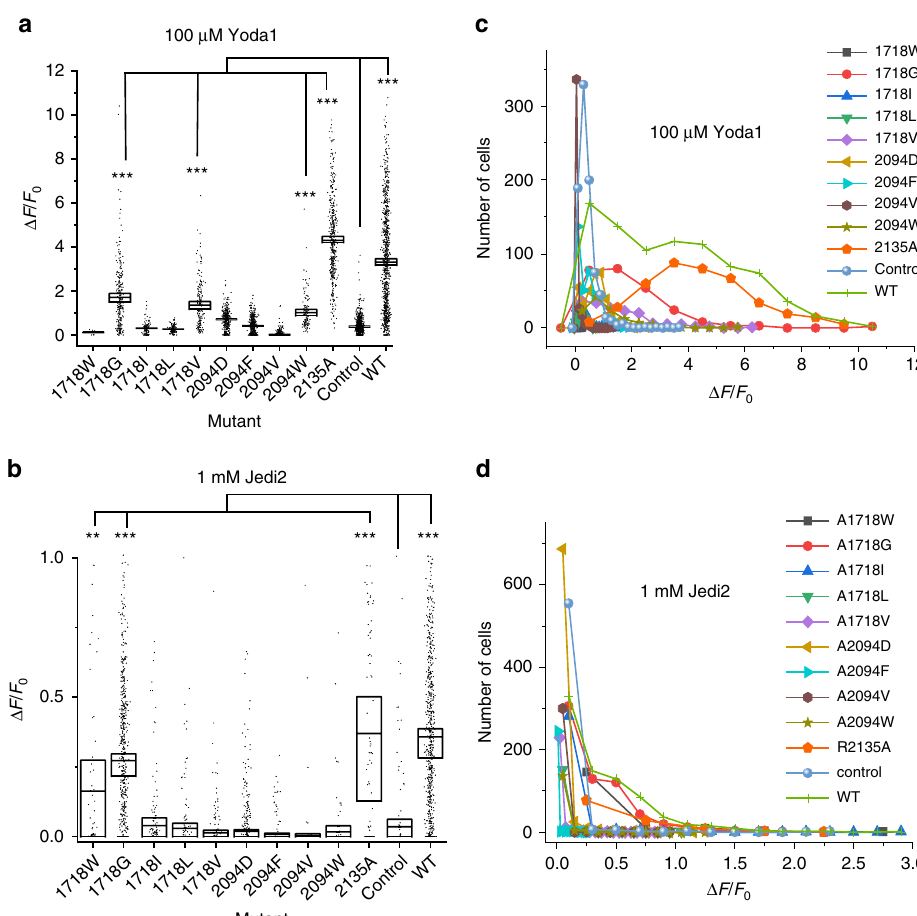
Fig. 4 Coupling between chemical activation pathways in Piezo1. Δ PZ1 cells were co-transfected with GC6 and one of the indicated A1718 and A2094 mutant construct or with GC6 only (control). The relative amplitude of calcium signals ( Δ F/F 0 ) obtained by application of 100 µ M Yoda1 ( a ) or 1 mM Jedi2 ( b ) is shown as a dotted box plot. For statistical analysis, cells from at least three independent experiments were pooled and considered as independent points (n values between 12 and 877). The box upper and lower limits represent standard error of mean values (shown as horizontal inner lines). Source data are provided as a Source Data fi le. Comparison of the mean values between WT/mutants and control was done using two-tails t -tests. Asterisks indicate standard p -value range. *, 0.01 < p < 0.05; **, 0.00 1 < p < 0.01; ***, p < 0.001 and n.s. (non-signi fi cant): p > 0.05. Statistical results are only shown for mutants exhibiting Δ F/F 0 larger than control conditions. For clarity, the number of analyzed cells is from (a) and (b) are plotted as function of the range of Δ F/F 0 values obtained with 100 µ M Yoda1 ( c ) or 1 mM Jedi2 ( d ) for each tested mutant (gray rectangle: A1718W, red circles: A1718G, blue triangles: A1718I, green triangles: A1718L, purple diamonds: A1718V, gold triangles: A2094D, cyan triangles: A2094F, brown hexagons: A2094V, olive stars: A2094W, orange pentagons: R2135A, blue spheres: control and green